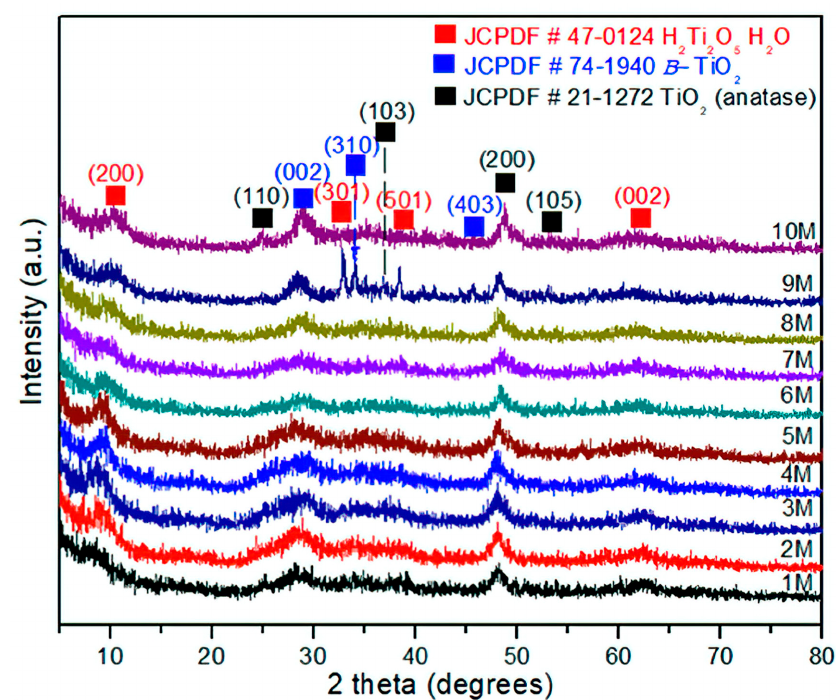
Figure 4. XRD of the TiO 2 -anatase samples treated with NaOH at concentrations of 1–10 M by the hydrothermal process.